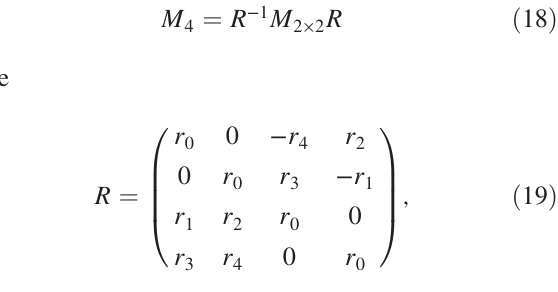
FIG. 13. Frequency spectra for h y i and h y 2 i . The four plots depict the spectra for tunes, 0.34, 0.36, 0.38 and